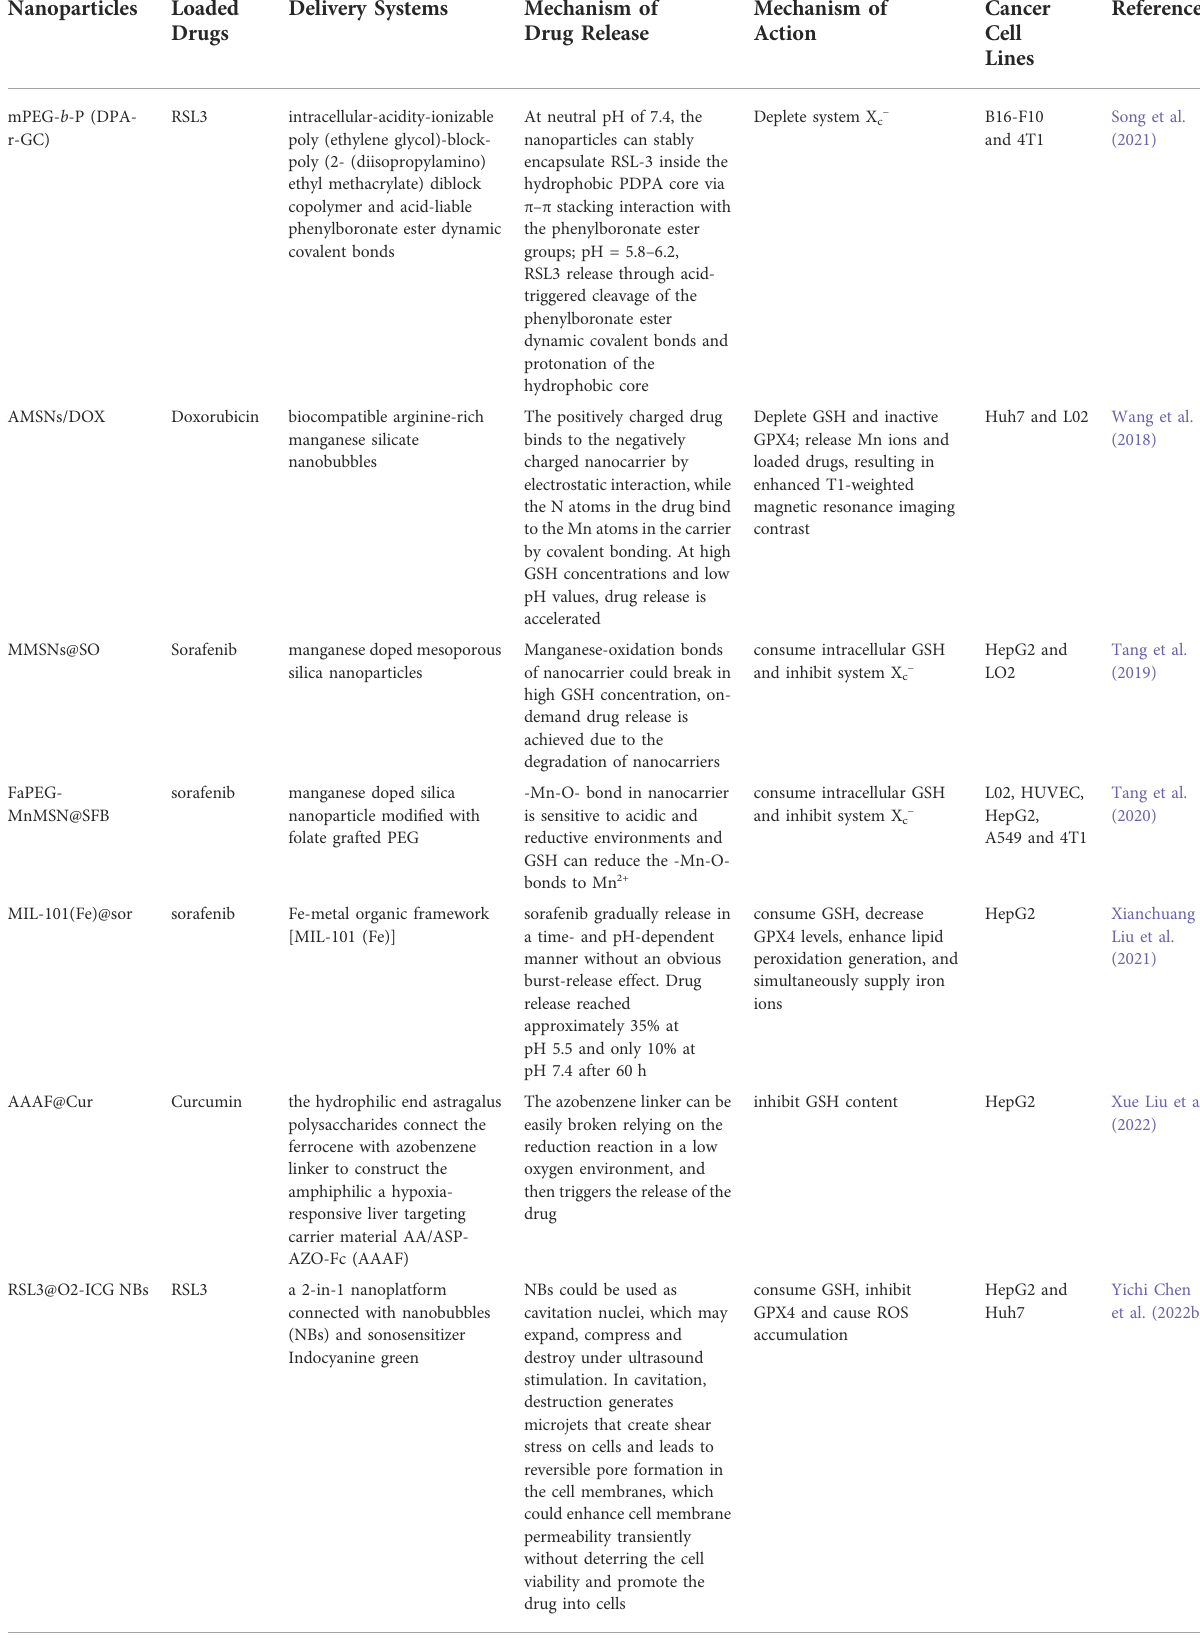
TABLE 3 Novel nano drug delivery systems inducing ferroptosis in solid tumors via System Xc-/GSH/GPX4 axis.